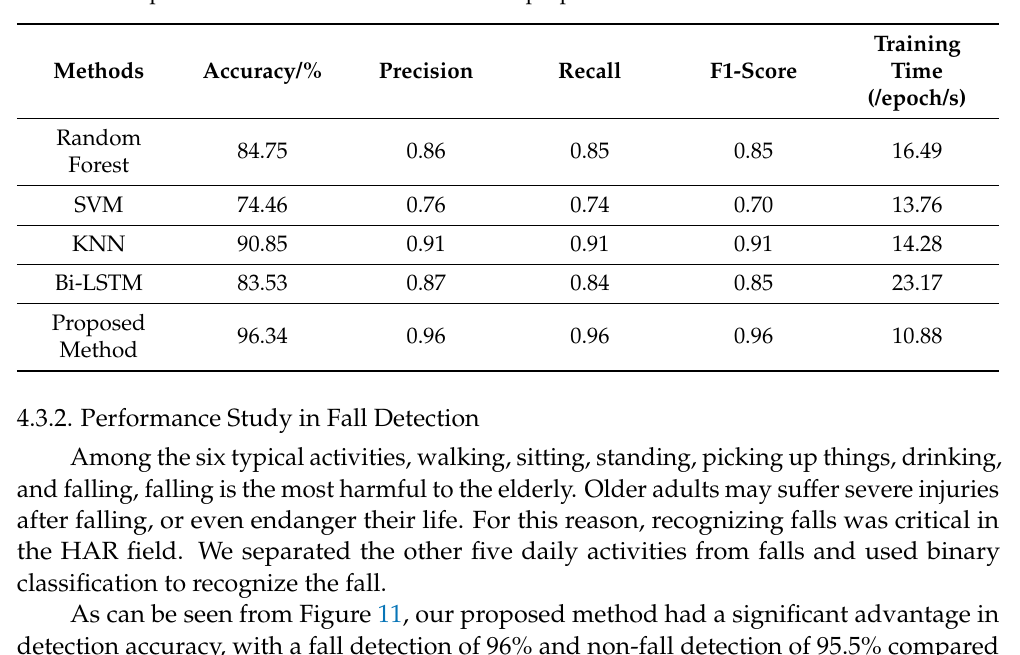
Table 4. Comparison of different methods with the proposed